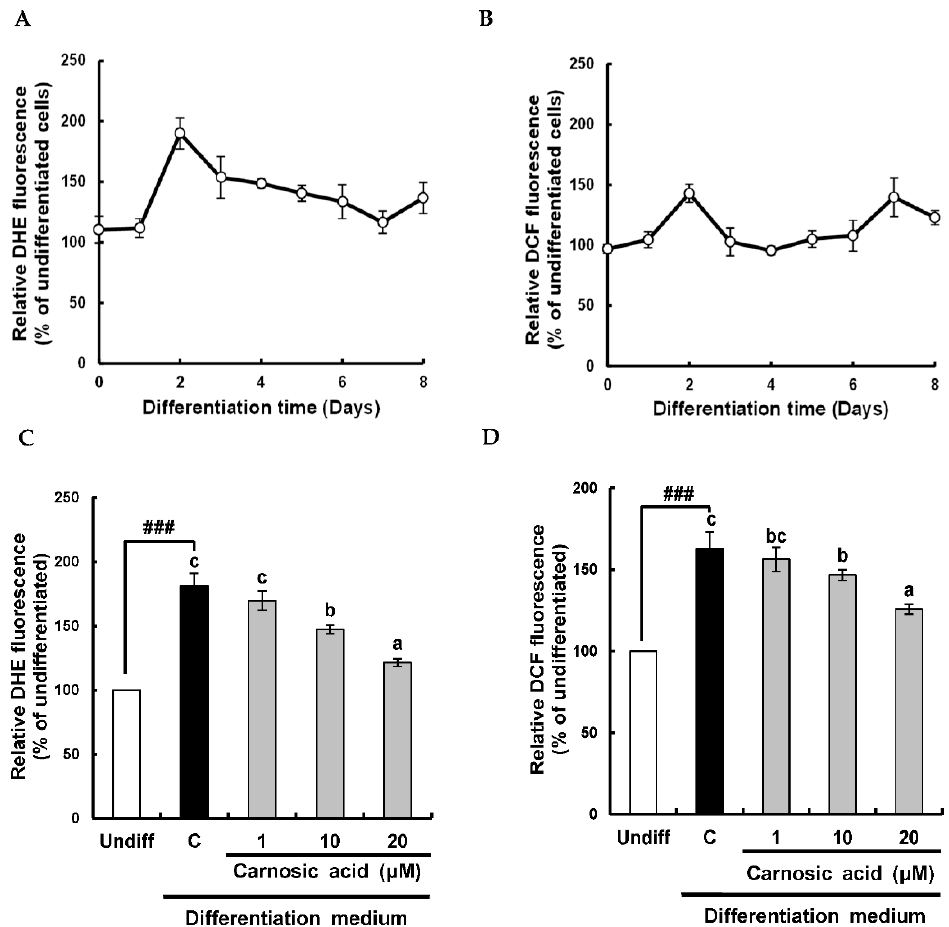
Figure 1. Carnosic acid suppresses superoxide anion and ROS levels in MDI-induced differentiation of 3T3-L1 pre-adipocytes into adipocytes. ( A ) Change of superoxide anion levels during adipogenesis. ( B ) Change of ROS levels during adipogenesis. ( C ) Carnosic acid suppressed superoxide anion levels after differentiation for two days. ( D ) Carnosic acid suppressed ROS levels after differentiation for two days. Data are presented as averages of three independent experiments performed in triplicates and expressed as percentages of the value of the control (means ± standard error mean, n = 3). ### : p < 0.001 vs. Undiff. Different corresponding letters indicate significant differences at p < 0.05 using Duncan’s test. (Undiff: undifferentiated, which was not treated with the MDI hormone mixture; C: control, which was treated with the MDI hormone mixture).